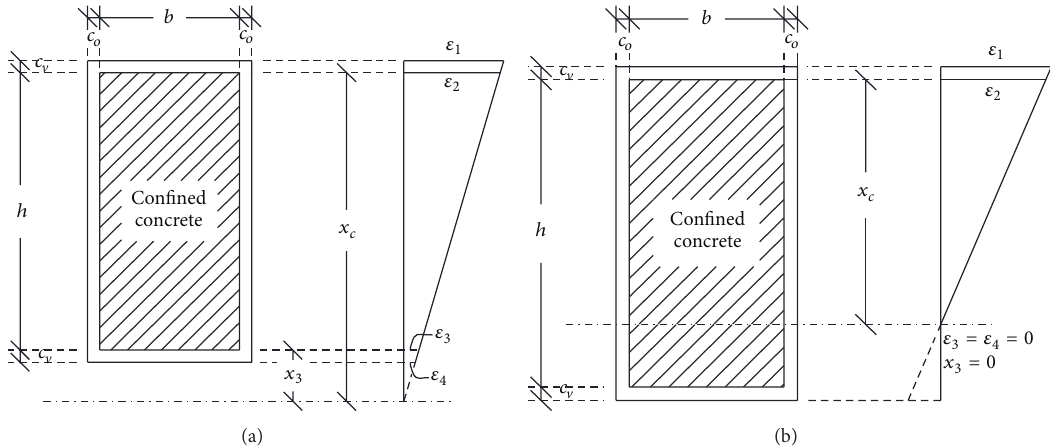
Figure 6: Strain state of concrete section: (a) uncracked section; (b) cracked